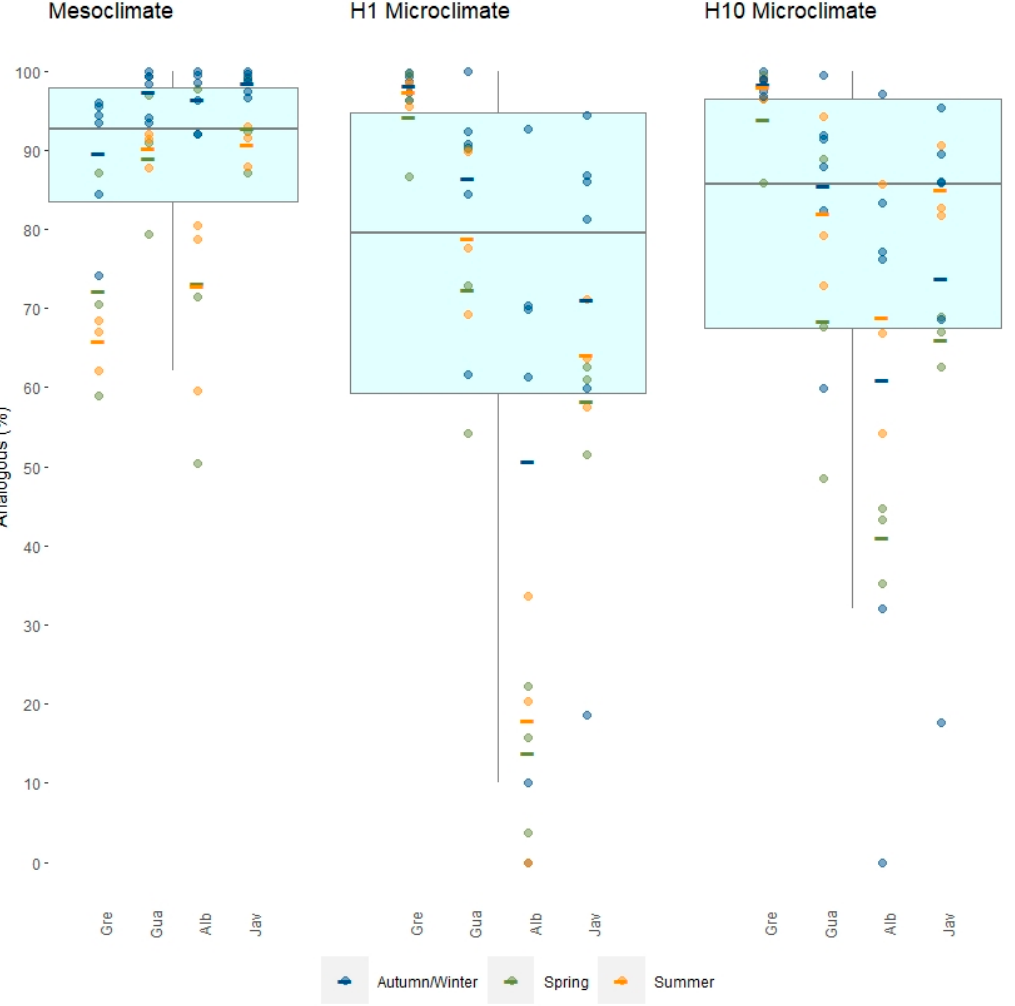
Figure 5. The percentage of pixels showing analogous temperatures between 1980–1989 and 2010– 2019. Mesoclimate data—1 km resolution in 50 × 50 km cells; microclimate models—30 m resolution in 6 × 6 km cells for H1—pine forest and H10—grassland. Points show % analogous monthly maxima for the four regions; coloured bars show means per season in each region. Box plots show median and interquartile range for all data at meso ‐ or microscales for the respective habitats.